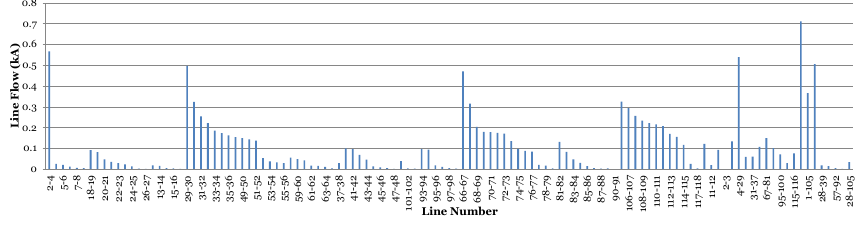
Figure 4. Line flows for 119 node